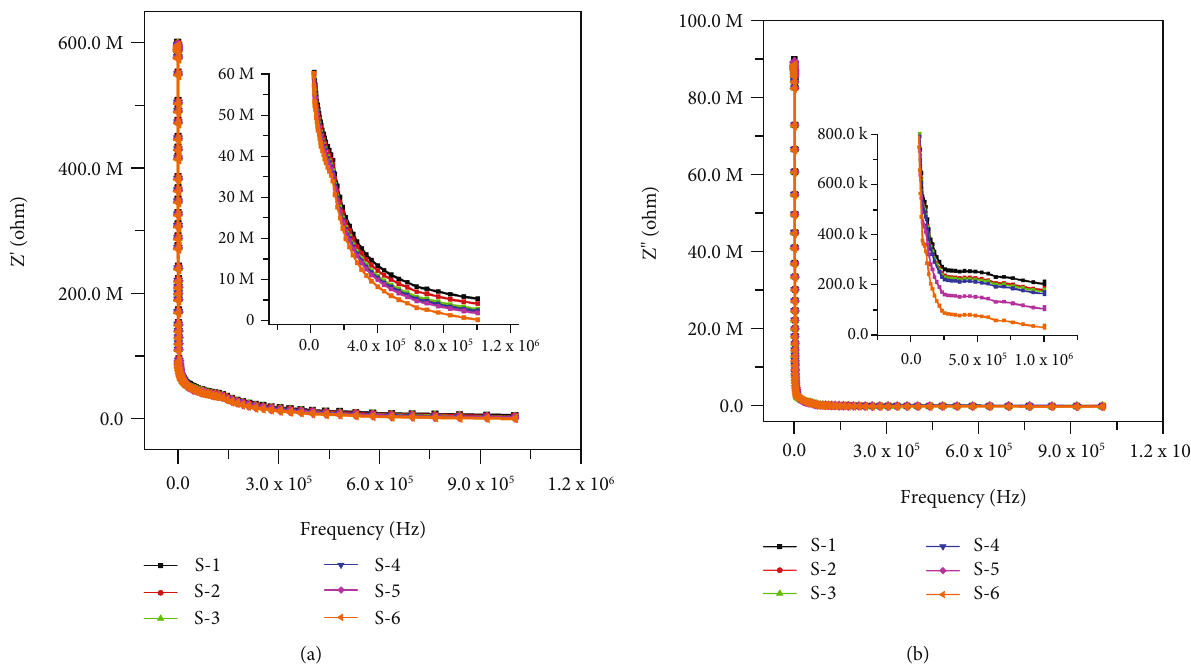
Figure 9: Variation in Z ′ (a) and Z ″ (b) of synthesized PVDF and PVDF-based NC FSs with increasing frequency. Table 3: Comprehensive review of various parameters of synthesized PVDF and PVDF-based NC FSs. Sample